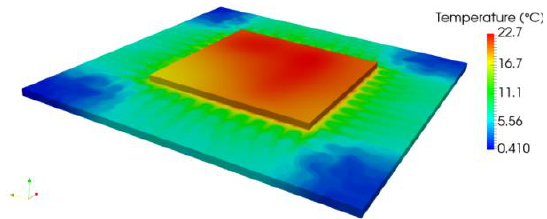
Figure 11. Temperature field for three active heat sources.